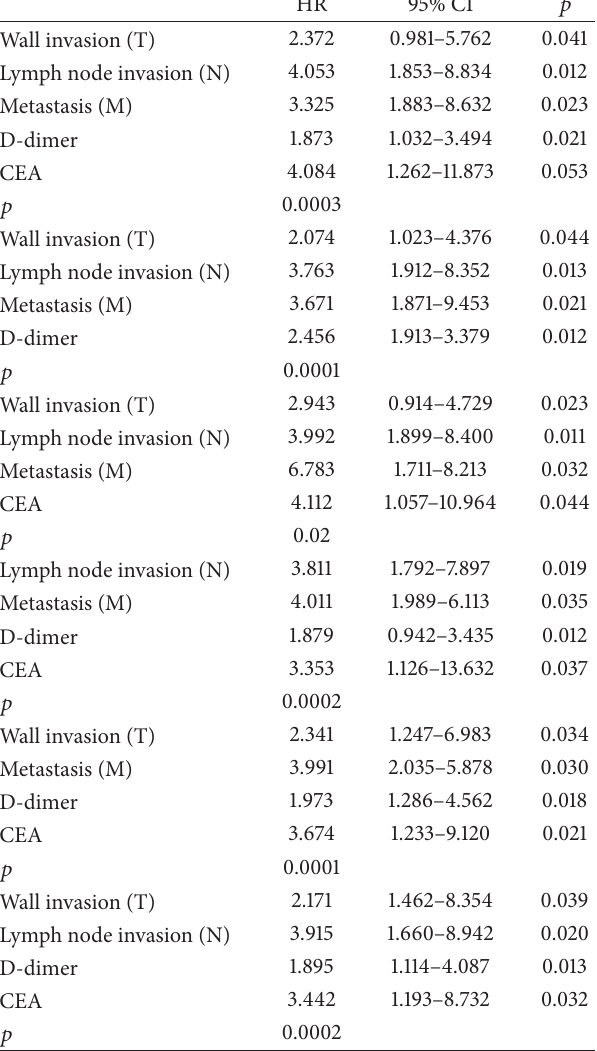
Table 3: Multivariate analysis of the significant variables deter- mined by univariate